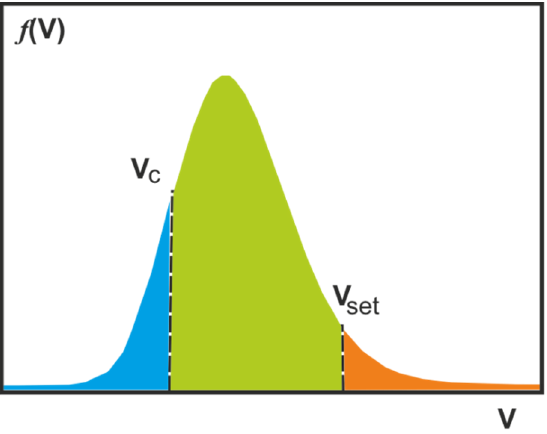
Figure 5. Schematic diagram of the energy barrier to reversal in the AF layer. A critical difference between the behavior of MnN and IrMn is that the peak in the loop shift as a function of t AF occurs at much lower thicknesses (~8 nm) for the latter. This is probably due to the lower magnetocrystalline anisotropy of MnN (~6 × 10 6 erg/cm 3 ) compared to that of IrMn (up to ~3 × 10 7 erg/cm 3 ). A second factor that controls the